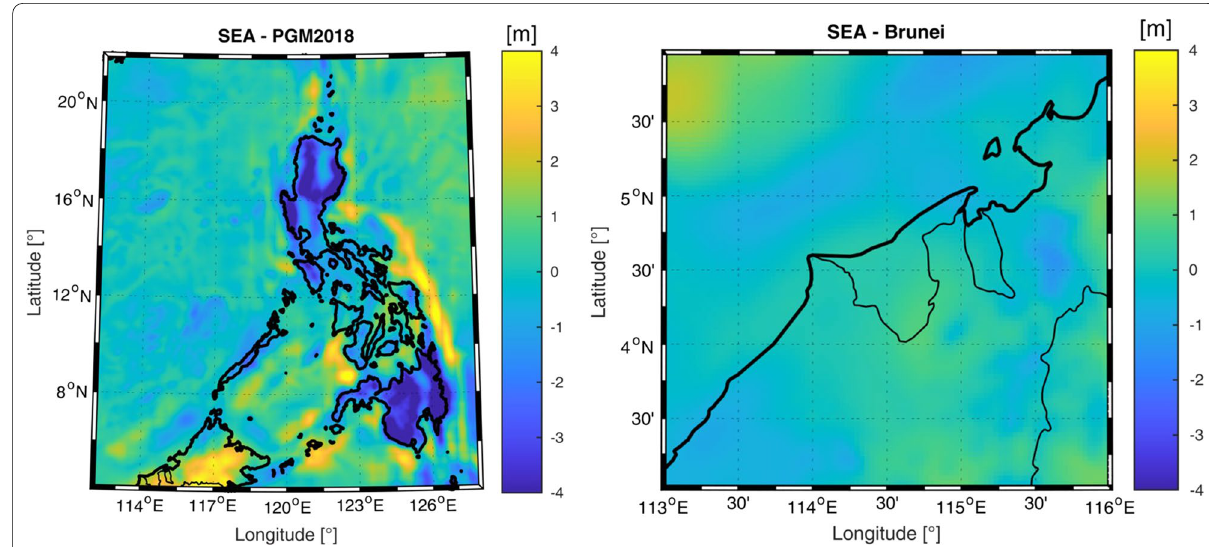
Fig. 2 Residuals of the comparison of SEA regional geoid model with respect to PGM2018 and Brunei local geoid models. The colour bars of the comparisons with SEA are saturated in the range 4 m and 4 m. For visualization purposes the spatial resolution of the figures was increased −